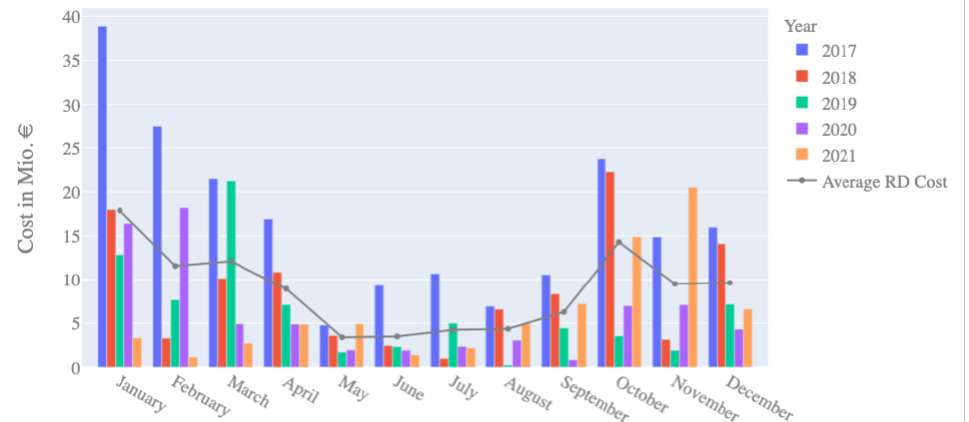
Figure 6. Cost for redispatch measures in the 50 HzT grid since 2017, varying over the time of the